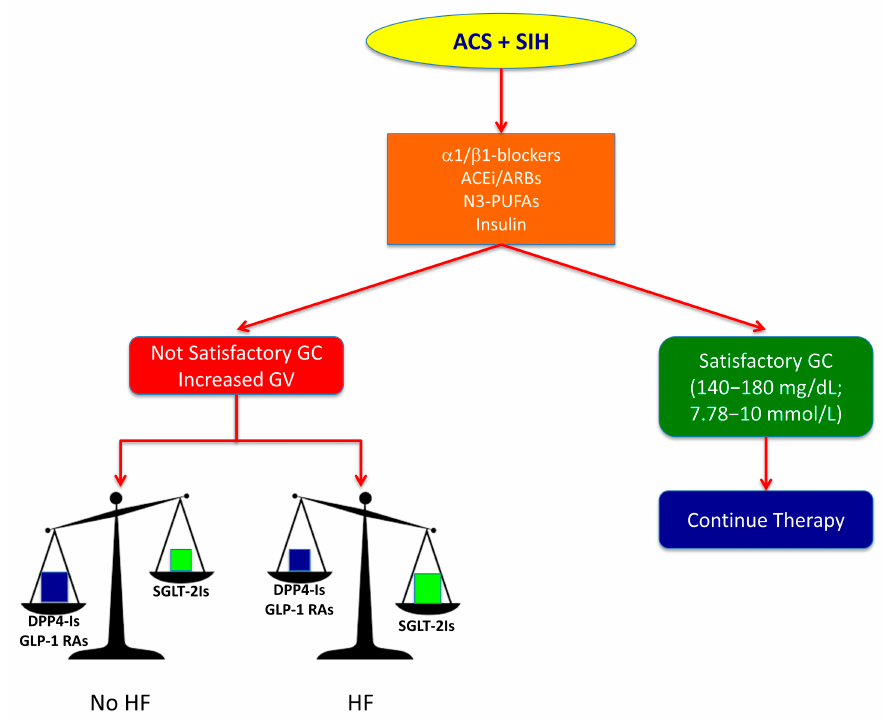
Figure 2. Proposal for a multitargeted therapeutic strategy to improve the prognosis in non- diabetic patients with stress-induced hyperglycaemia (SIH) at admission for acute coronary syn- drome (ACS). Pharmacological therapy for SIH in non-diabetic ACS patient should start with administration of α 1/ β 1-blockers, ACE inhibitors (ACEi) or angiotensin receptor blockers (ARBs) and n3-polyunsaturated fatty acids (n3-PUFAs) in addition to insulin. If this strategy reaches an efficient glycaemic control (GC) within the recommended range (140–180 mg/dL; 7.78–10 mmol/L), it may be continued without any change. Conversely, if glycaemic values are not satisfactory and glycaemic variability (GV) increases, we can implement this therapy with dipeptidyl peptidase-4 inhibitors (DPP-4Is) or glucagon like peptide-1 receptor agonists (GLP-1 RAs) in patients without signs of or risk factors for heart failure (HF), whereas sodium-glucose co-transporters 2 inhibitors (SGLT-2Is) must be preferred in patients with signs of or risk factors for